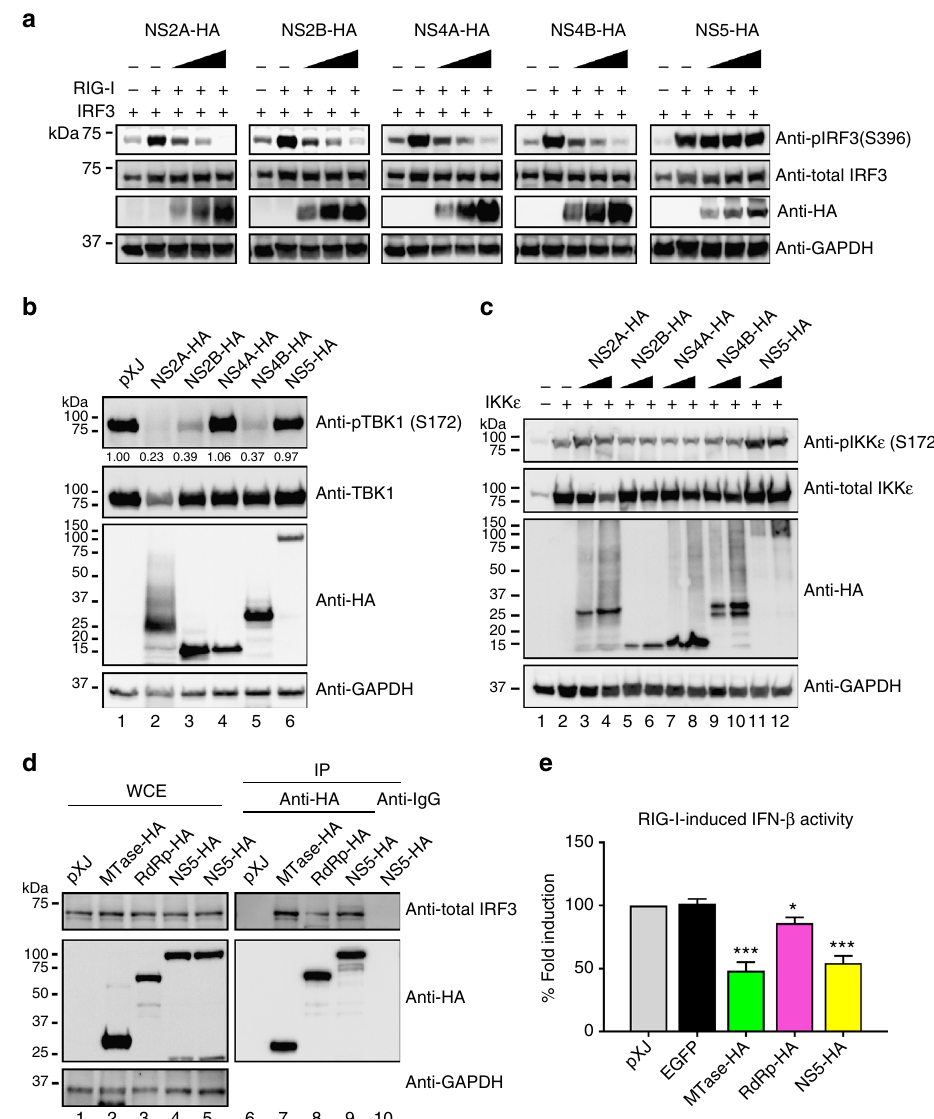
Fig. 2 ZIKV non-structural proteins inhibit TBK1s and IRF3 activation. HEK-293T cells were co-transfected with IRF3-expressing plasmid together with RIG-I (2CARD)-coding plasmid ( a ), TBK1-expressing plasmid ( b ), or IKK ε -expressing plasmid ( c ), as well as ZIKV non-structural protein-expressing plasmid or empty vector plasmid. Cells were harvested at 24 h post-transfection and subjected to western blotting with indicated antibodies, phosphorylated IRF3 (anti-pIRF3 S396), total IRF3 (anti-IRF3), phosphorylated TBK1 (anti-pTBK1 S172), total TBK1 (anti-TBK1), phosphorylated IKK ε (anti-pIKK ε S172), total IKK ε (anti-IKK ε ), GAPDH (anti-GAPDH), and ZIKV proteins (anti-HA). All viral proteins were cloned from the pre-epidemic, Cambodian strain ZIKV (FSS13025) isolated from a patient in 2010. d Co-immunoprecipitation of NS5 and IRF3. HEK-293T cells were transfected with HA-fused MTase-, RdRp-, or full-length NS5-expressing plasmid and RIG-I(2CARD) stimulating plasmid. At 24h post-transfection, cells were harvested and whole-cell extracts (WCE) were loaded as input (left panel). WCE were used for immunoprecipitation using anti-HA beads or anti-mouse IgG as a negative control, followed by detection of IRF3 using anti-total IRF3 antibody (right panel). The levels of proteins were quantitated by band intensity using Image lab software (BioRad). For a – d , the original uncropped blots can be found in Supplementary Fig. 5. e Luciferase assay of IFN- β promoter. MTase-, RdRp-, or NS5-expressing plasmid was co-transfected with RIG-I (2CARD) and reporter plasmids to HEK-293T cells. Cells were assayed for luciferase signals at 24 h post- transfection. Data are shown as mean ± SD from three independent experiments. Statistical signi fi cance was determined by Student ’ s two-sided t- test, * P < 0.05, *** P < 0.001, or no signi fi cance NS5 on the phosphorylation of TBK1, IKK ε , and IRF3 (Fig. 2). manner (Fig. 2a). The phosphorylation of TBK1 was suppressed HEK-293T cells were co-transfected with three plasmids: one by NS2A, NS2B, or NS4B, but not NS4A or NS5 (Fig. 2b). In expressing individual viral protein with an HA-tag; the second contrast, none of these viral proteins affected IKK ε phosphor- expressing IRF3; and the third expressing the constitutively ylation (Fig. 2c). These results suggest that different ZIKV pro- activated form of RIG-I. At 24 h post-transfection, the phos- teins antagonize IFN- β production through distinct cellular phorylation status of TBK1, IKK ε , and IRF3 was analyzed by components from the RIG-I pathway: (i) NS2A, NS2B, and NS4B western blot. The phosphorylation of IRF3 was inhibited by block TBK1 phosphorylation, (ii) NS4A suppresses IRF3 phos- NS2A, NS2B, NS4A, or NS4B, but not NS5, in a dose-dependent phorylation, and (iii) NS5 inhibits a step downstream of IFR3